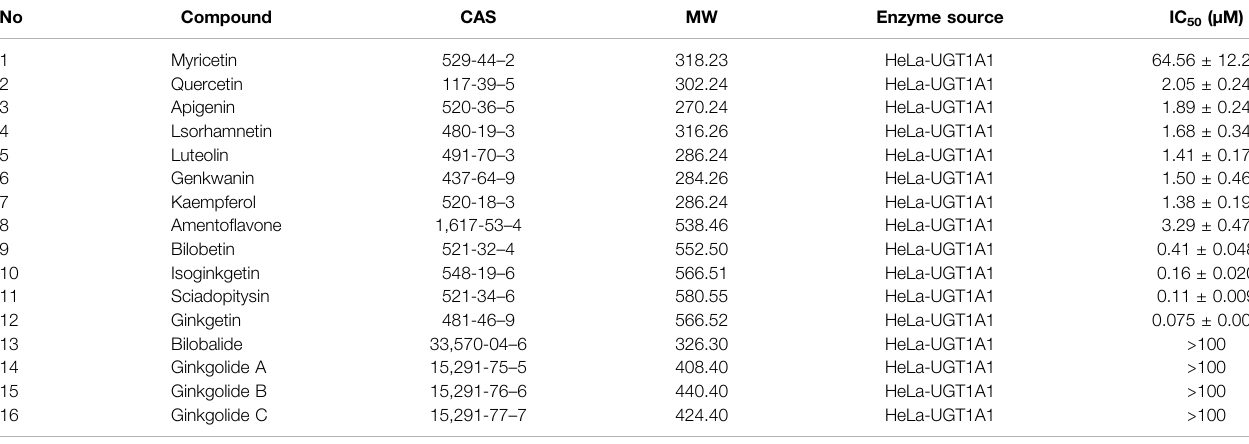
TABLE 1 | The IC 50 valuses of chemical constituents of ginkgo biloba extract on hUGT1A1-catalyzed NHPN- O -glucuronidation in HeLa-UGT1A1 cells. No